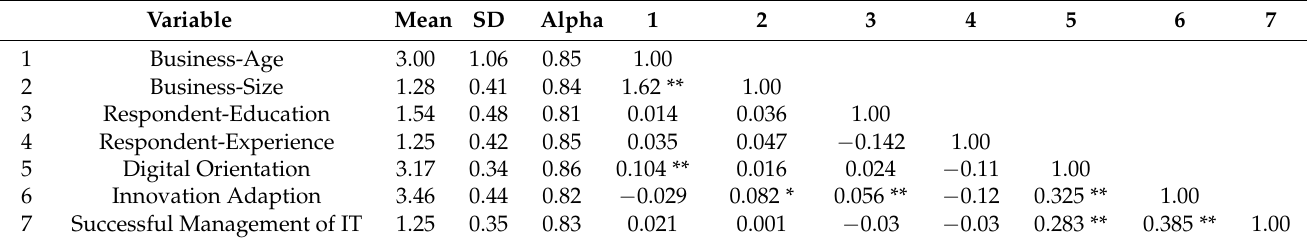
Table 3. Correlations.